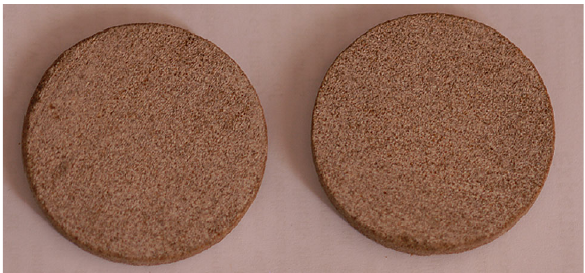
Fig. 9 Mineral plate form sandstone core plug